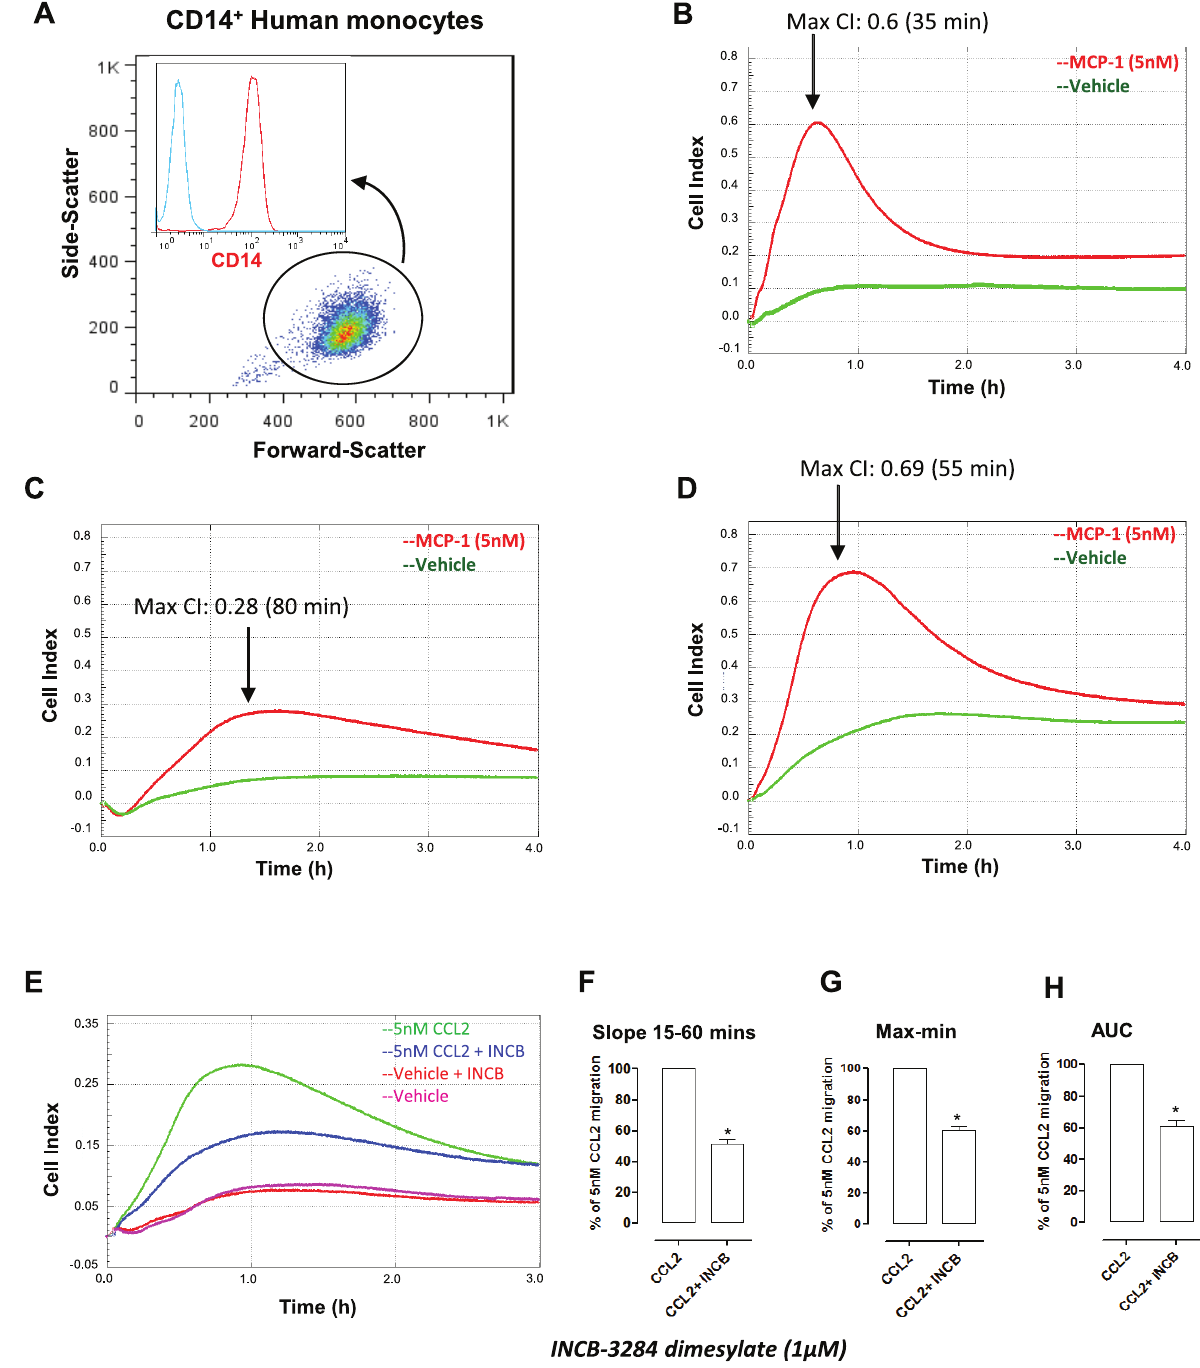
Figure 6. Analysis of chemotaxis responses in human monocytes reveals distinct donor to donor variation. Panel ( A ) shows a representative FACS plot of human monocytes following isolation by CD14 positive selection (Inset panel red=CD14 + ; blue= isotype control Ab). Panels B, C, and D are individual traces from three independent donors measuring monocyte (4 6 10 5 total) chemotaxis toward 5 nM human CCL2. ( E ) The inhibitory action of an anti-CCR2 drug (INCB-3284 dimesylate) was also tested with human monocytes. Human monocytes were pre- incubated with INCB-3284 (1 m M) for 90 mins at 37 u C and allowed to migrate toward 5 nM CCL2 for 3 h. Data are shown as a percentage of 5 nM human CCL2 induced migration for ( F ) Slope ( G ) Max-min CI and ( H ) (AUC). Data are the mean 6 SEM of three independent experiments with four technical replicates per experiment. Statistical analysis was performed by one-way ANOVA and Dunnett’s multiple comparison post-test. *,p , 0.05 relative to CCL2 alone.